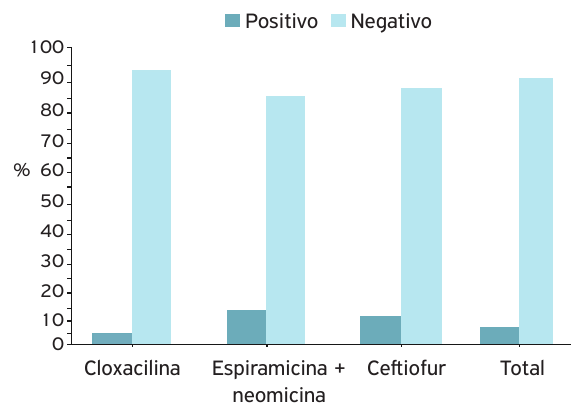
Figura 1. Resultado dos testes de resíduos de antimicrobianos em 47 amostras de leite de 19 novilhas e 28 vacas tratadas no período pré-parto. Rondônia,